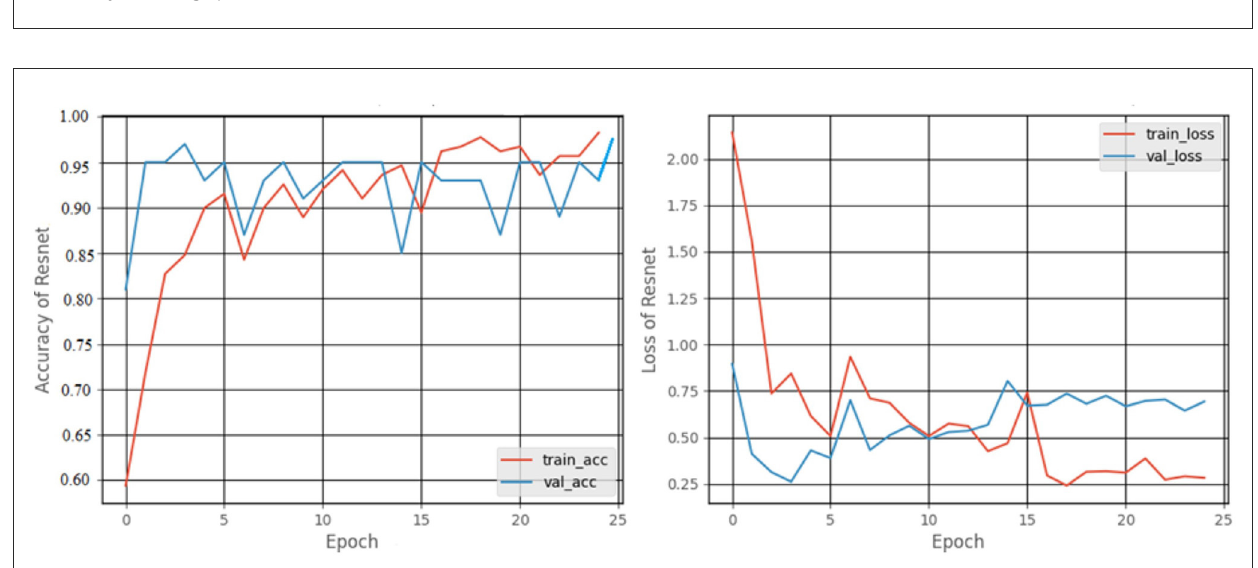
FIGURE11 Accuracy and loss graphs for the VGG-16 model.